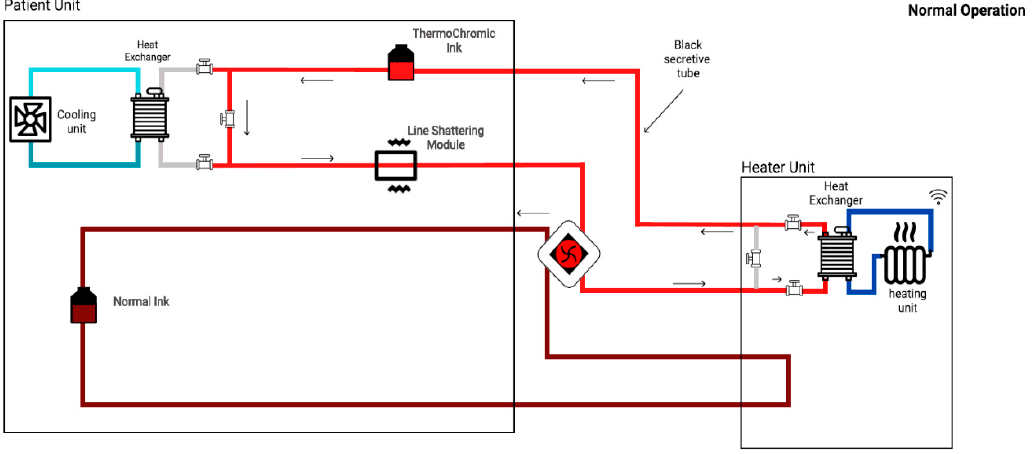
Figure 7. Oxygenation process.